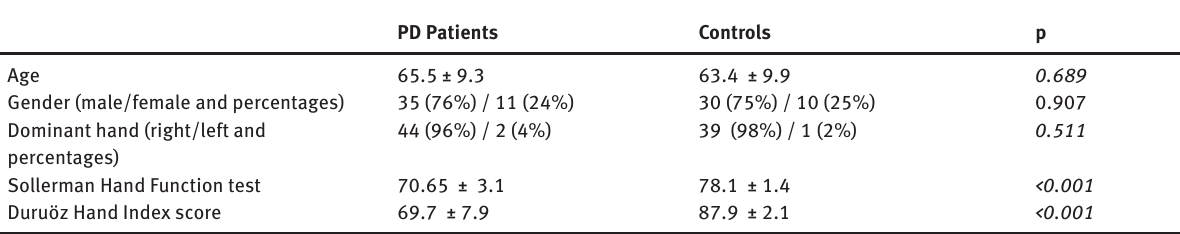
Table 1: Demographic data and hand function test scores assigned to PD patients and healthy controls, and the significance of the diffe- rence between